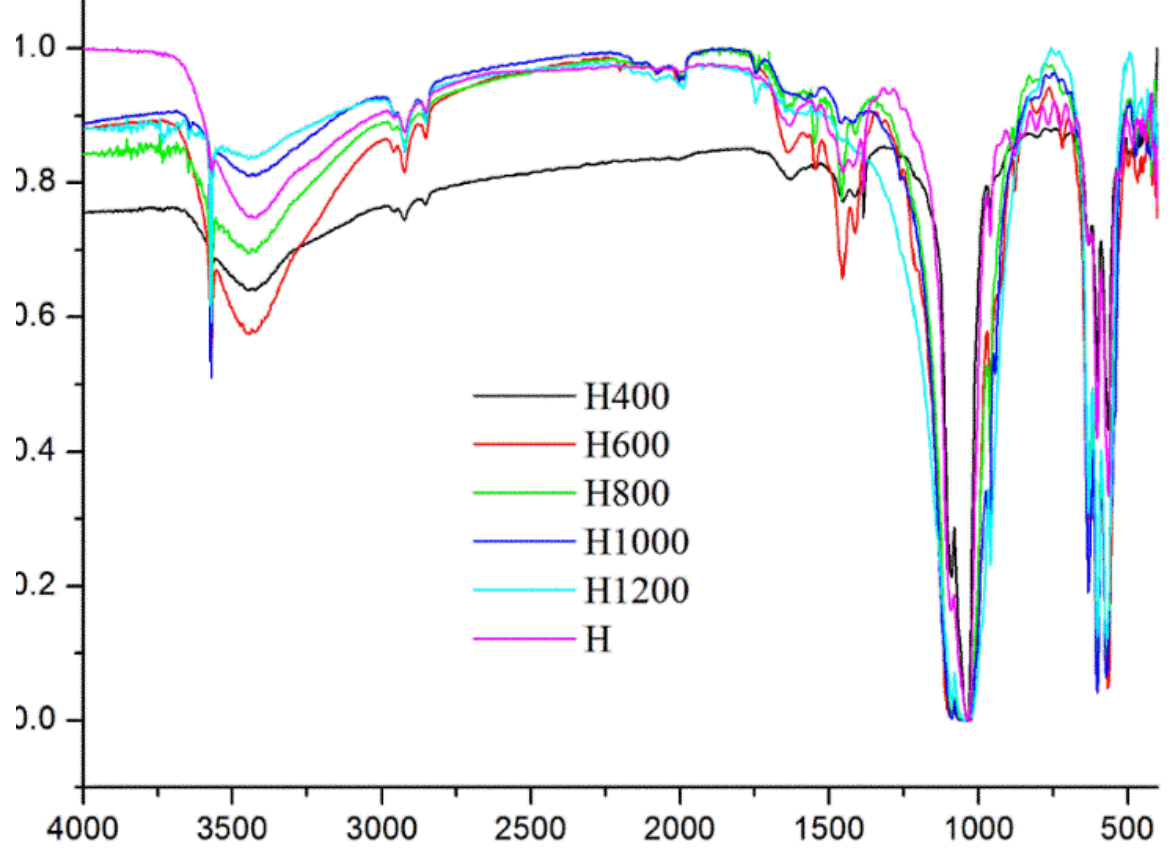
Figure S7: FT-IR spectrum of the hydroxyapatite with increasing sintering